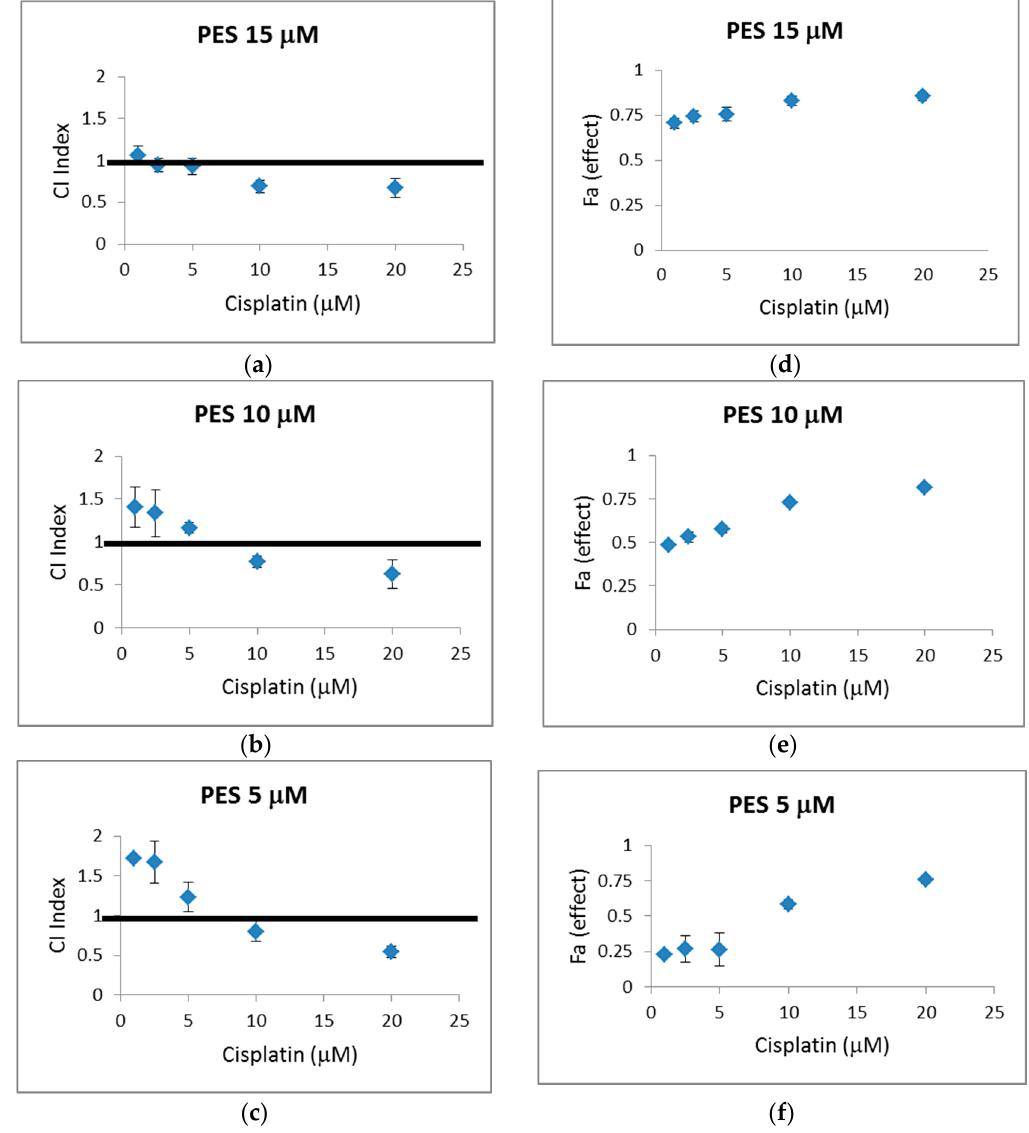
Figure 2. CI values for pifithrin- μ (PES) at 15 μ M ( a ); 10 μ M ( b ) and 5 μ M ( c ) in combination with 1, 2.5, 5, 10, and 20 μ M cisplatin against HT29 cells. CI (Combination index) is a quantitative definition for synergism where CI < 1, antagonism where CI > 1 and additive effect where CI = 1. The average ± SEM of three independent experiments relative to control, ≤ 0.2% DMSO treated cells. Fa effect for pifithrin- μ (PES) at 15 μ M ( d ); 10 μ M ( e ) and 5 μ M ( f ) in combination with 1, 2.5, 5, 10, and 20 μ M cisplatin. Fa (fraction affected) represents the respective proliferation inhibition, where 0% inhibition fa = 0% and 100% inhibition fa = 1. The average ± SEM of three independent experiments relative to control, ≤ 0.2% DMSO treated cells.